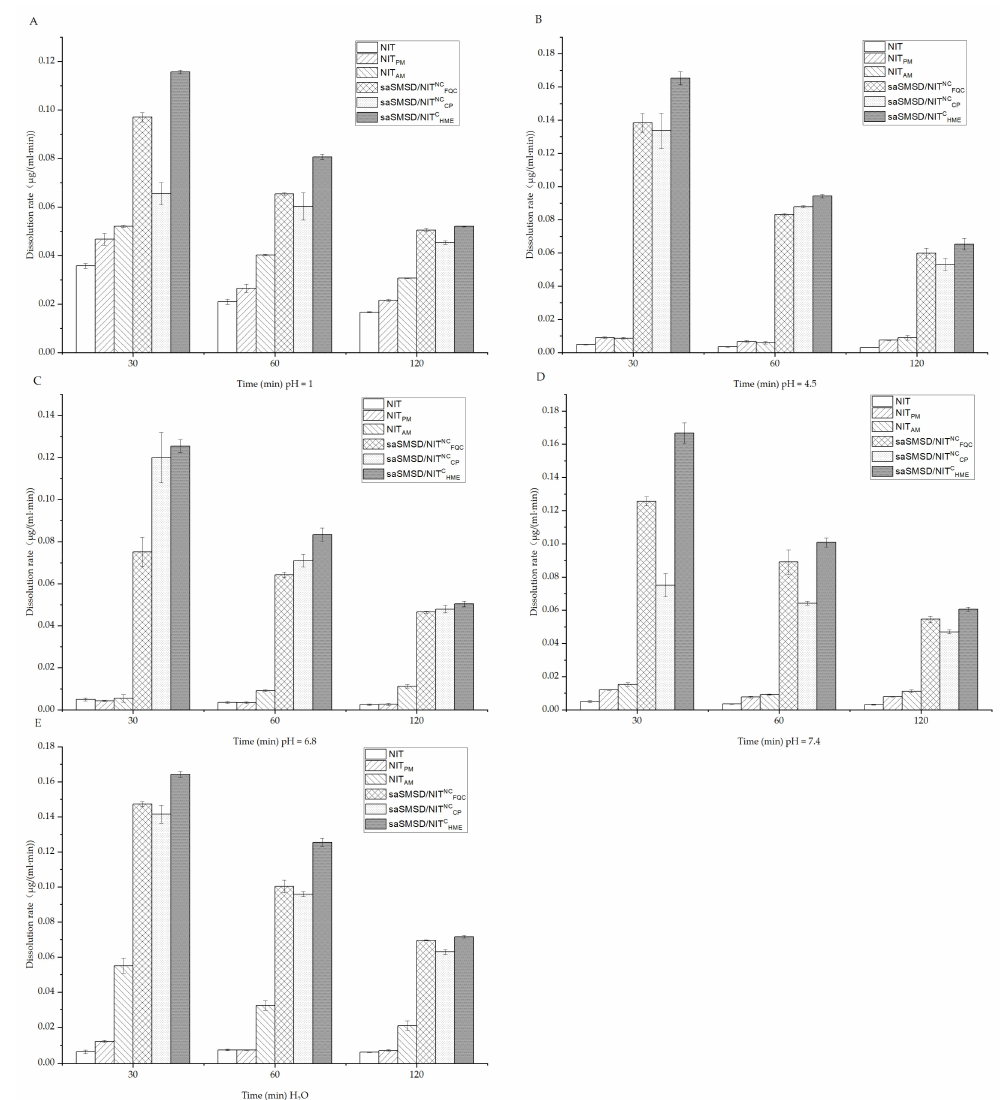
Figure 6. Dissolution rates calculated at 30, 60 and 120 min for NIT-related samples in 0.1 mol/L HCl ( A ); NIT-related samples in PBS (pH 4.5) ( B ); NIT-related samples in PBS (pH 6.8) ( C ); NIT-related samples in PBS (pH 7.5) ( D ); NIT-related samples in H 2 O ( E ). Standard deviations are expressed as error bars ( n =